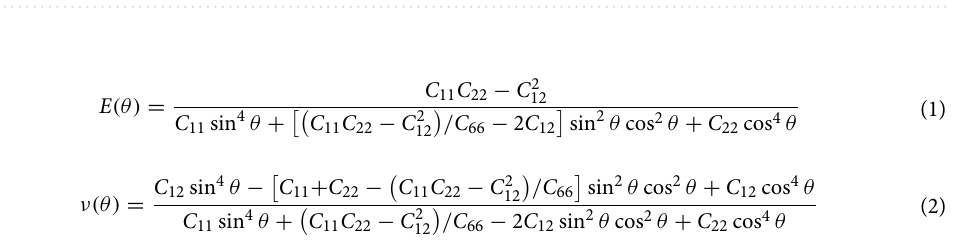
Figure 2. ( a ) Young’s moduli and ( b ) Poisson’s ratio of biphenylene; strain−stress relations along x and y directions under ( c ) uniaxial and ( d ) biaxial